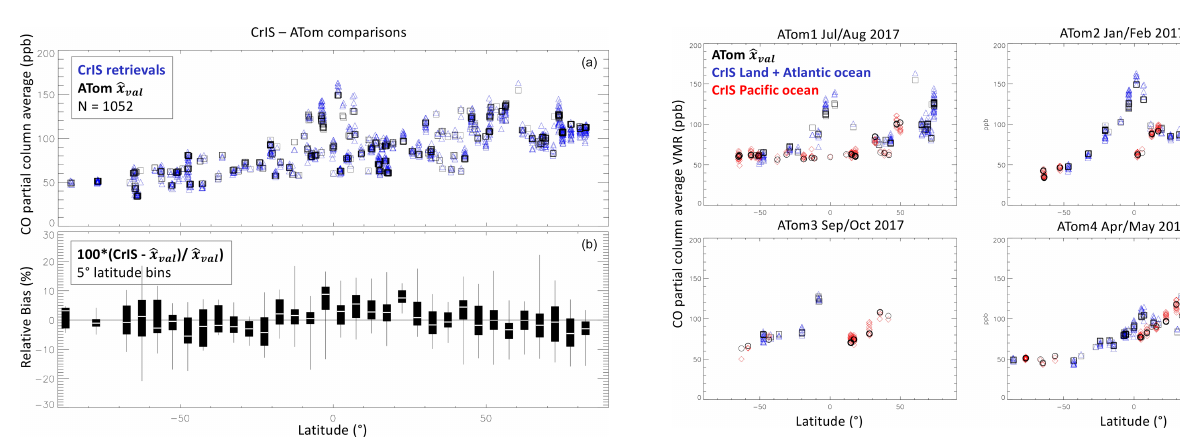
Figure 8. Latitude dependence of CO partial column average VMR (ppb) for TROPESS/CrIS retrievals and ATom ˆ x val (a) and bias dif- ference statistics (b) shown by box–whisker symbols representing minimum and maximum values (whisker), lower quartile (box bot- tom), median (white stripe), and upper quartile (box top). A mini- mum of five comparisons per bin was required.